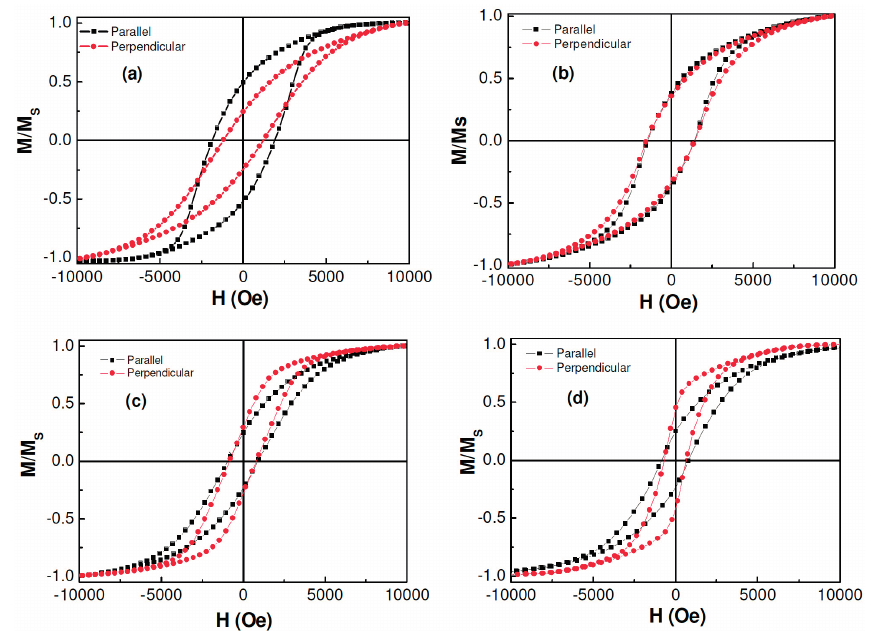
Figure 5. Magnetic hysteresis loops of CoNiP nanowires with different diameters of